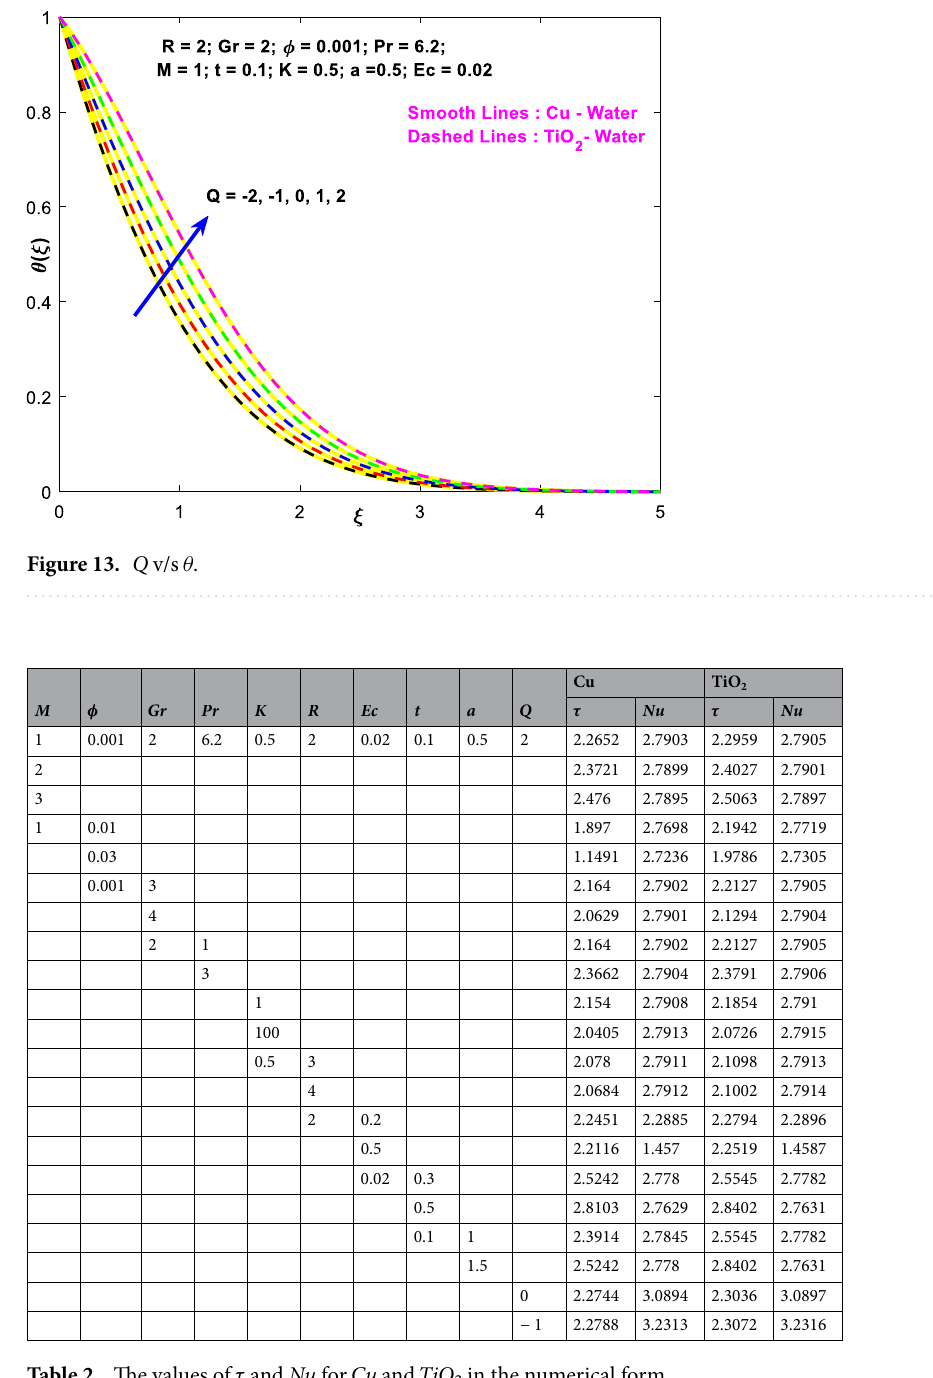
Table 2. The values of τ and Nu for Cu and TiO 2 in the numerical